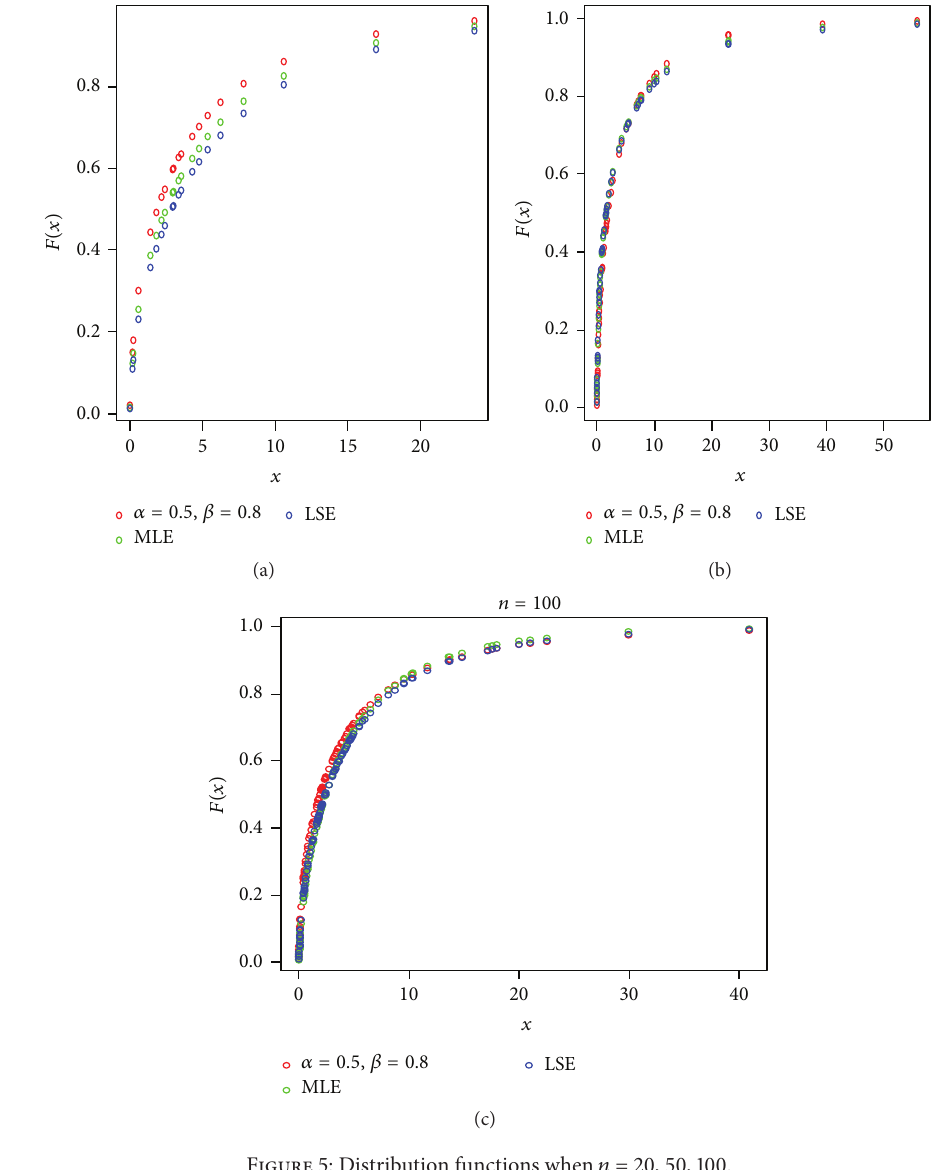
Figure 5: Distribution functions when 𝑛 = 20, 50,